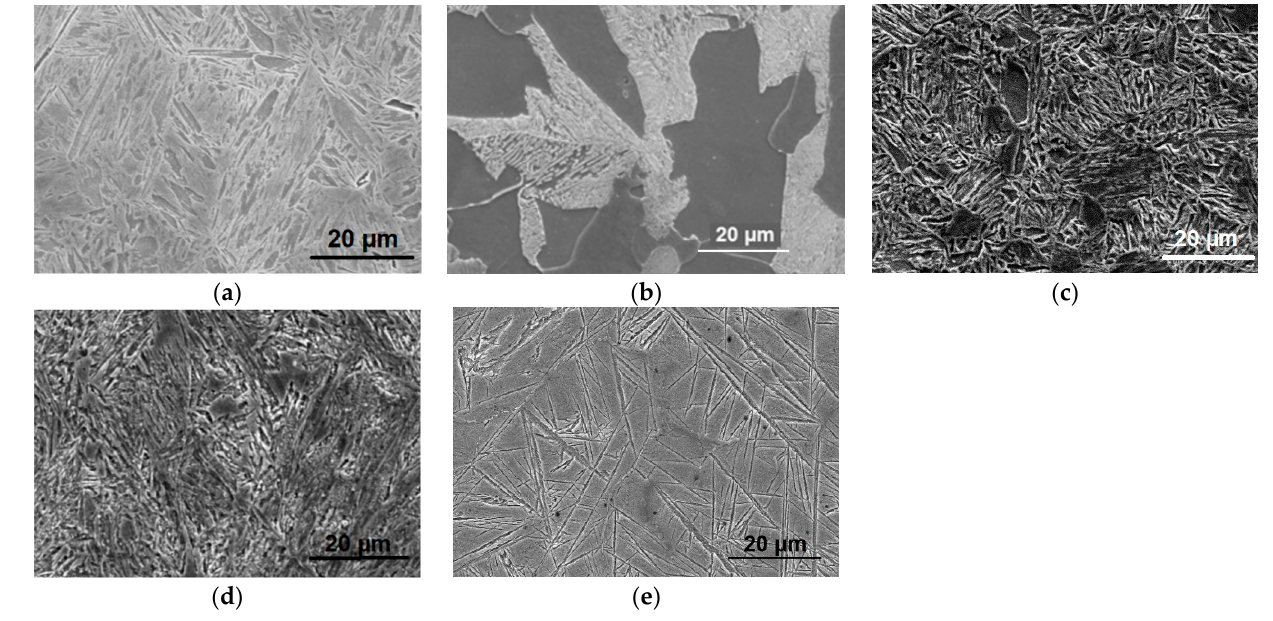
Figure 9. Microstructure of the materials; ( a ) 37MnSi5; ( b ) S355J2G3; ( c ) HARDOX 450; ( d ) hardfacing material OK 84.58; ( e ) hardfacing material UTP 690.